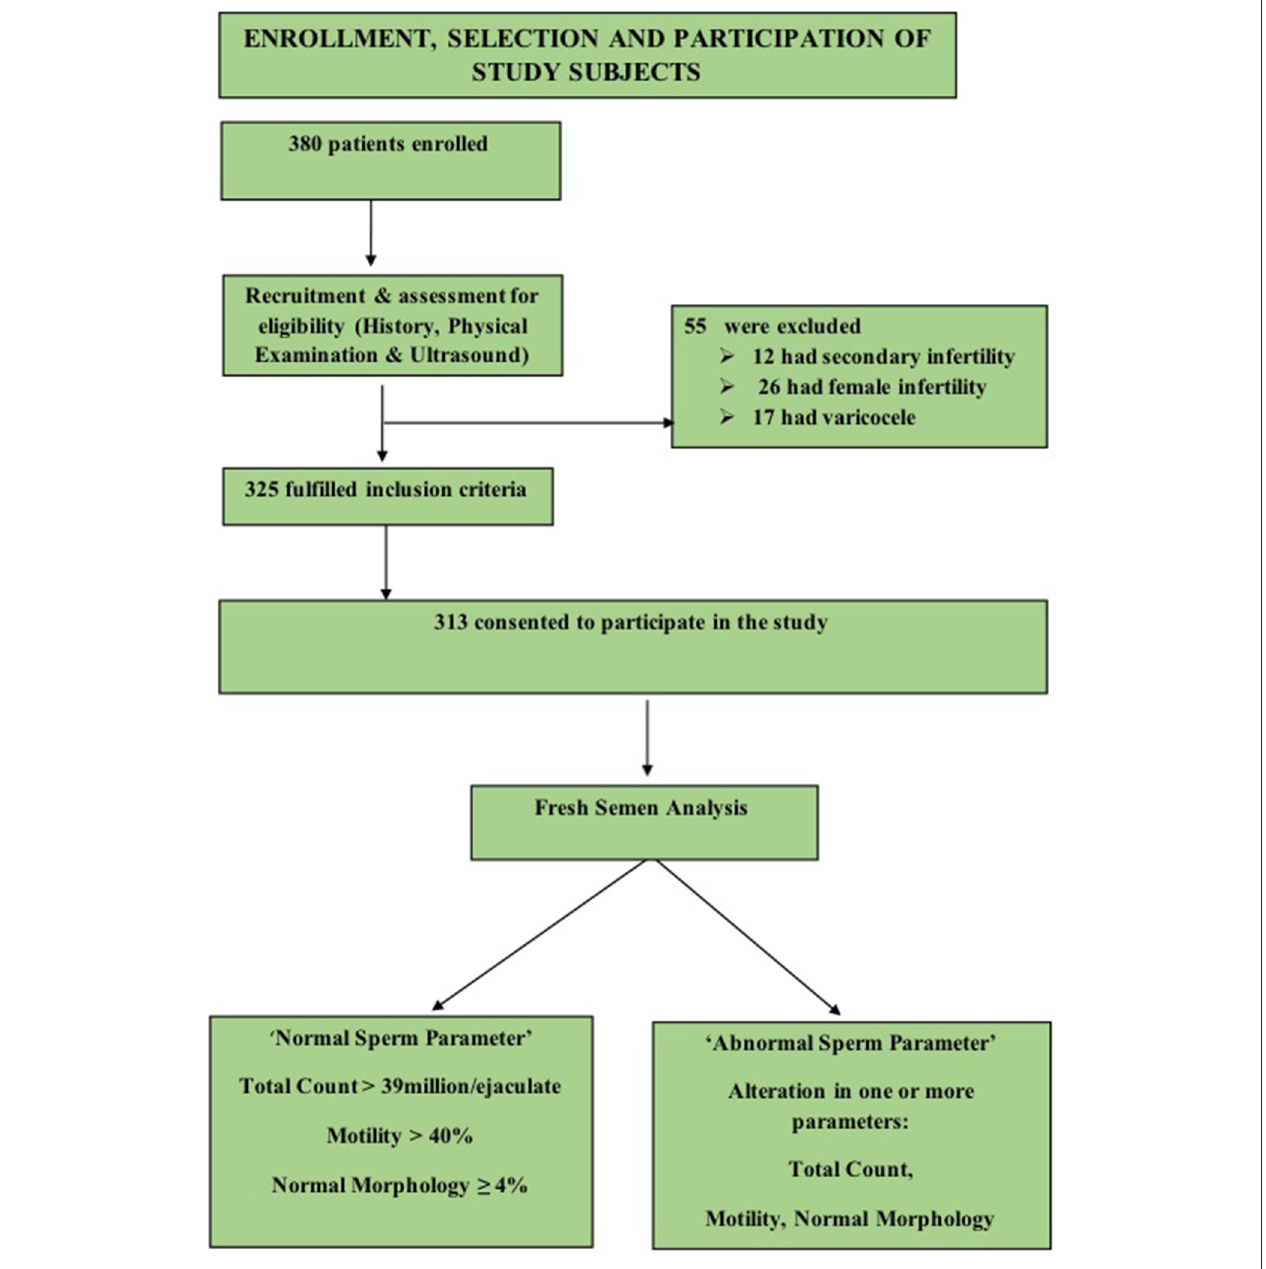
FIGURE 1 | Flow chart showing enrollment, selection and participation of